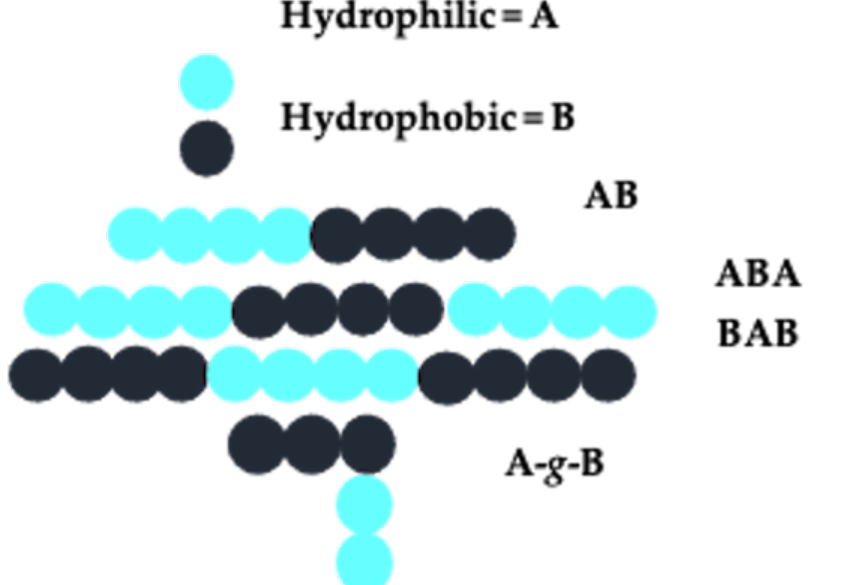
Figure 2. Amphiphilic block copolymers. Compounds made of identical or different types of homopolymer blocks that are covalently linked. Block copolymers of the form AB are known as diblock copolymers, of the form ABA or BAB are known as triblock copolymers, and of the form A- g -B or B- g -A are known as graft block